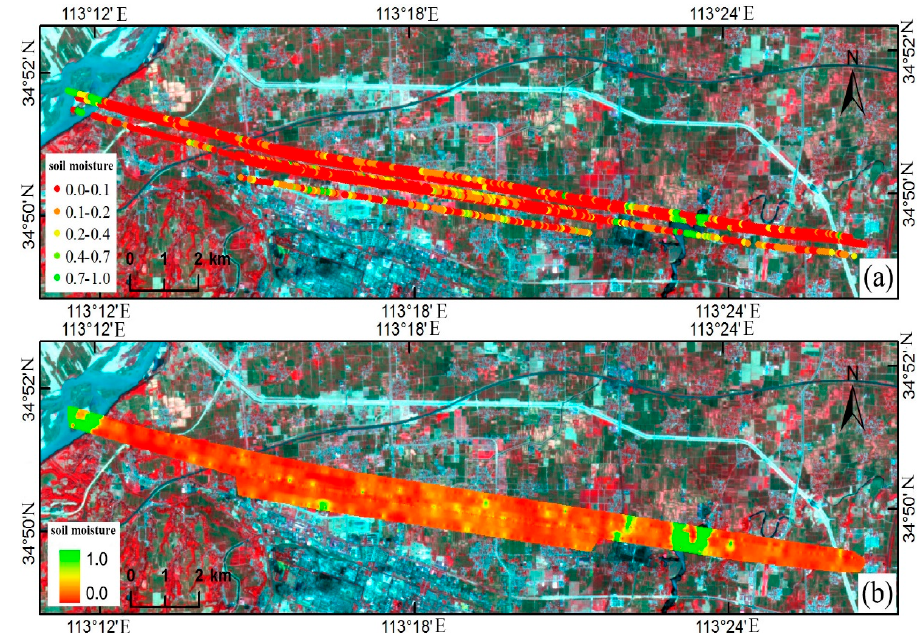
Figure 11. Soil moisture estimation result of an aviation experiment with GNSS-R over Zhengzhou. ( a ) Distribution of soil moisture at the specular reflection point; ( b ) soil water grid data (at a resolution of 20 × 20 m).